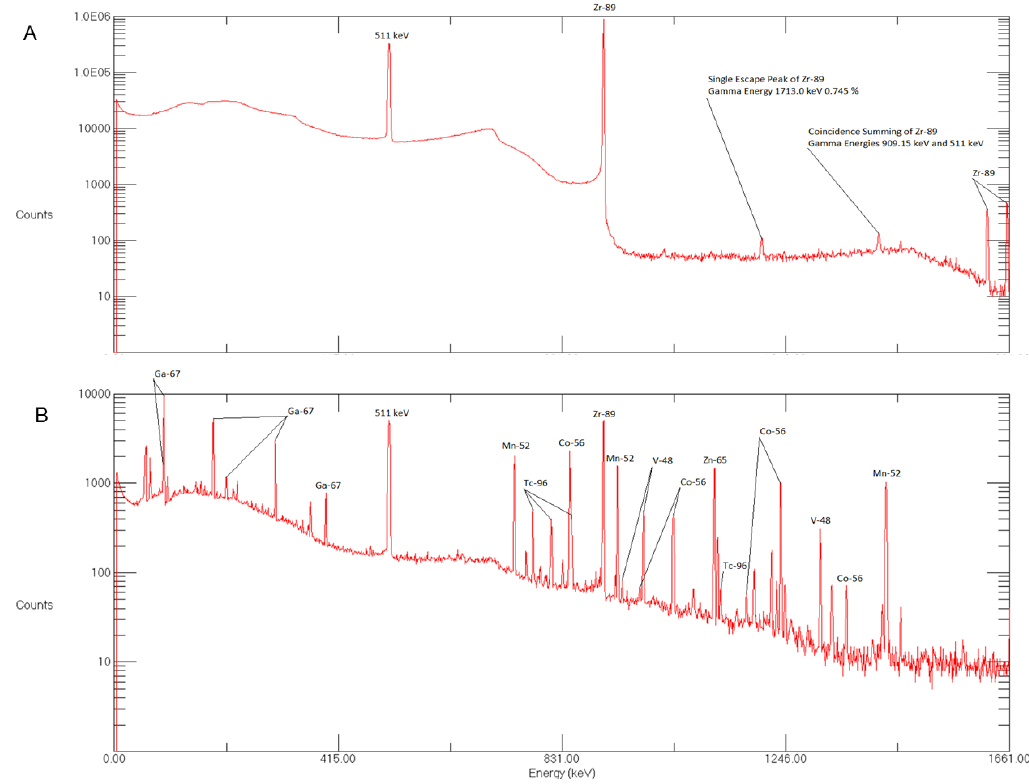
Figure 3. ( A ) Gamma spectrum of purified sample of 89 Zr taken 8h after the end-of-bombardment (EOB). ( B ) Gamma spectrum of impurities found in waste vial following 89 Zr production.